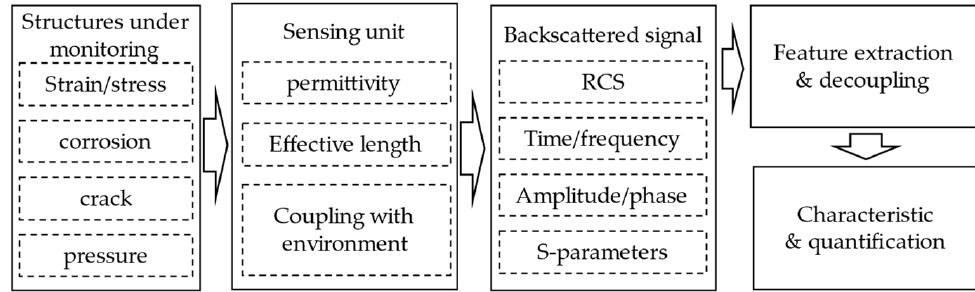
Figure 13. Sensing procedures of chipless RFID sensor tags.